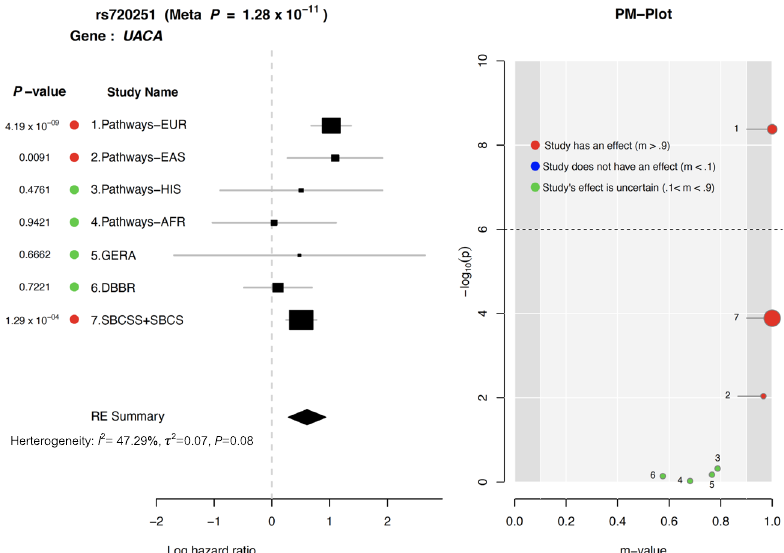
Fig. 7 Meta-analysis of rs720251 across all four independent prospective cohorts evaluated in this study. Pathways-EUR, Pathways-EAS, Pathways-HIS, and Pathways-AFR represents the European, East Asian, Hispanic, and African population of the Pathways Study respectively. GERA corresponds to the incident cases of European descent from the GERA cohort. SBCSS + SBCS represents the SBCSS and SBCS patients. Meta P -value was calculated using METASOFT based on Han and Eskin ’ s Random Effects model. The forest plot (left) displays P -value, study name, log hazard ratio and its standard error from the cox regression model of the corresponding study. The PM-Plot (right) displays the m - value (the posterior probability that the effect exists) of each study along with its P -value. The size of the symbol represents the study sample